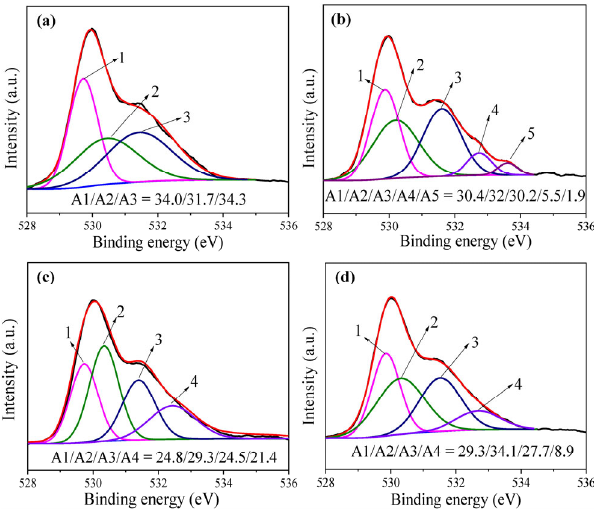
Fig. 12 XPS spectra of C 1s of the rubbed surfaces lubricate by PAO6 containing different mass concentrations of TiL 4 /BP nano- composites under the load of 20 N: (a) 0%, (b) 0.005%, (c) 0.01%, and (d) 0.05%.